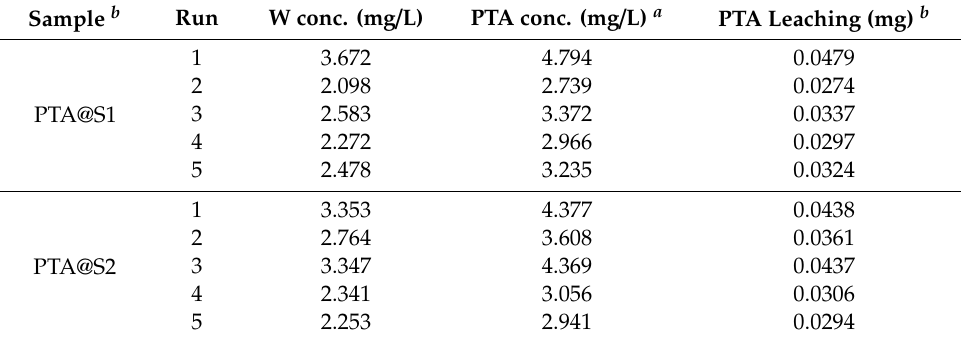
Table 3. The phosphotungstic acid (PTA) content of filtrate of catalyst for each run.